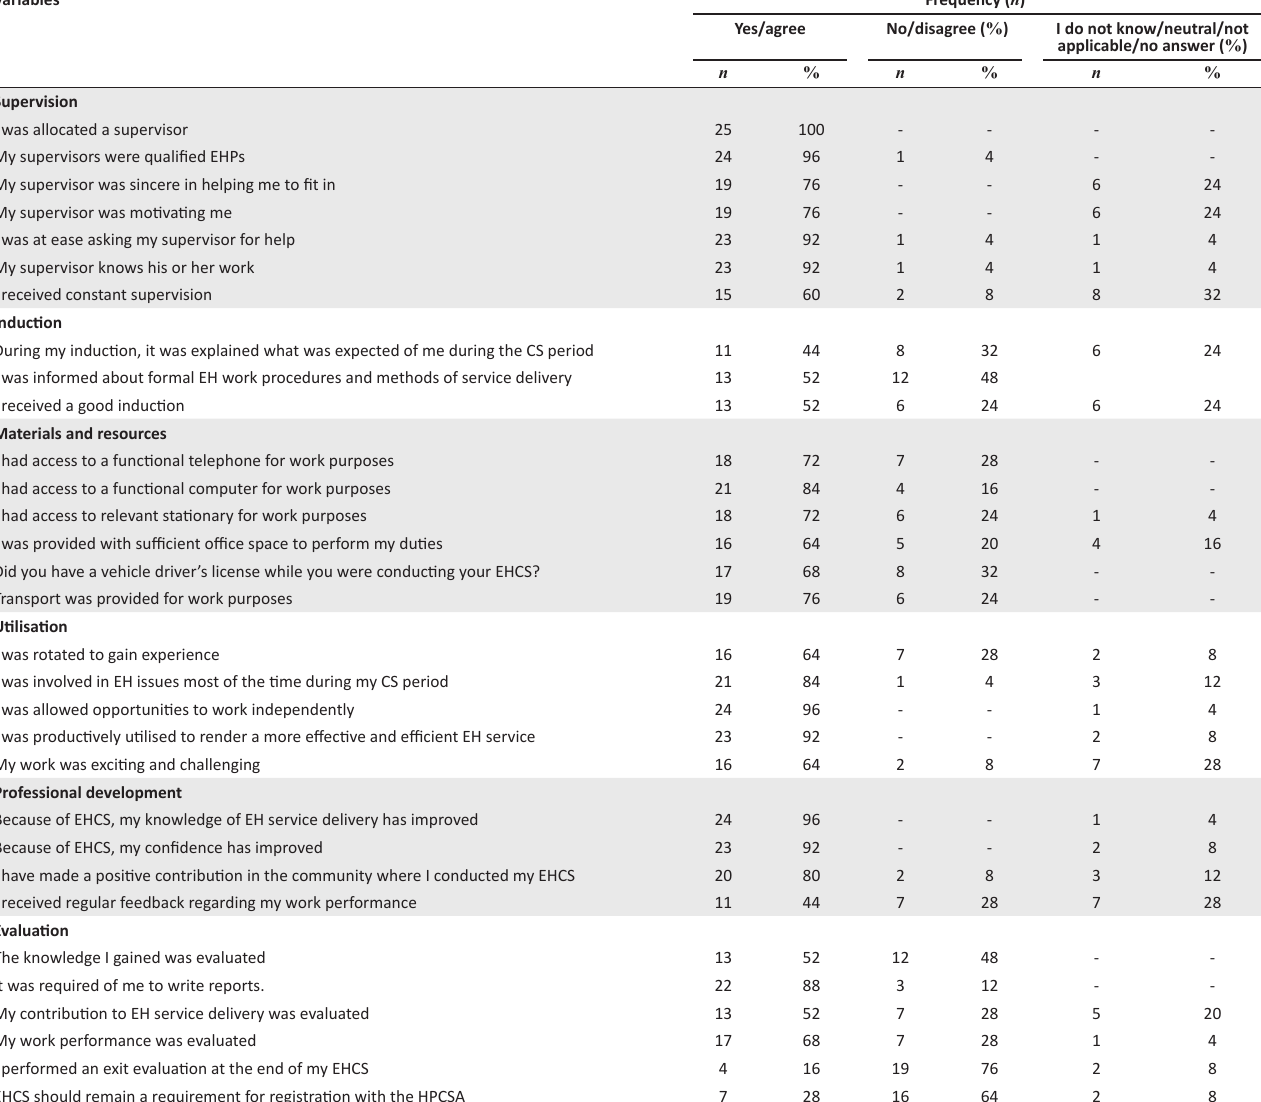
TABLE 3: Experiences of Environmental Health Community Service practitioners regarding utilisation and evaluation.